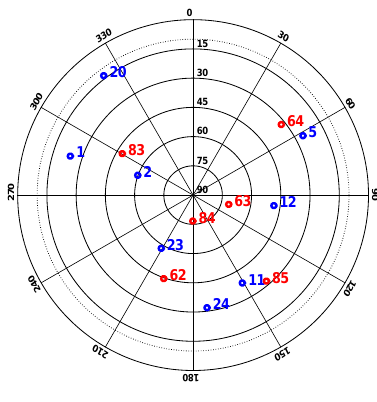
Figure 7. Skyplot for Delft, the Netherlands, showing satellite IDs of nominal GPS (blue) and planned Galileo (red) for the 3rd January 2001 at 2:00 a.m.